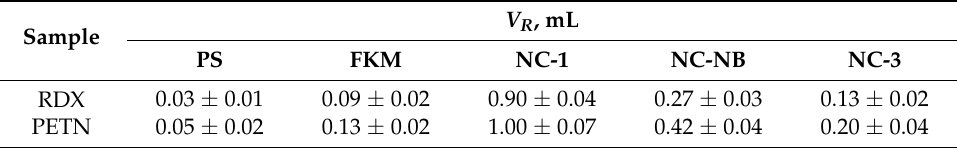
Table 2. The volume of gas released obtained by the vacuum stability test.